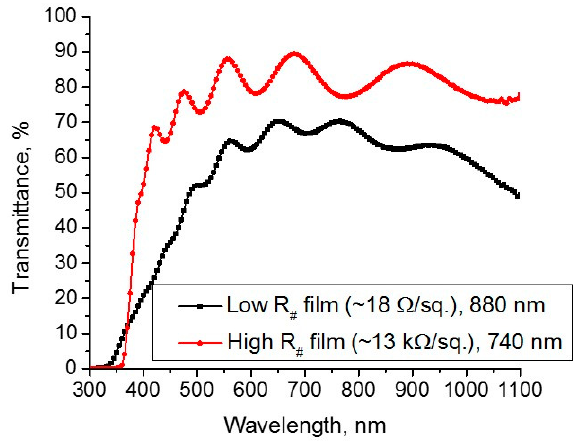
Figure 5. Transmittance characteristics of AZO thin films with low and high resistivity.